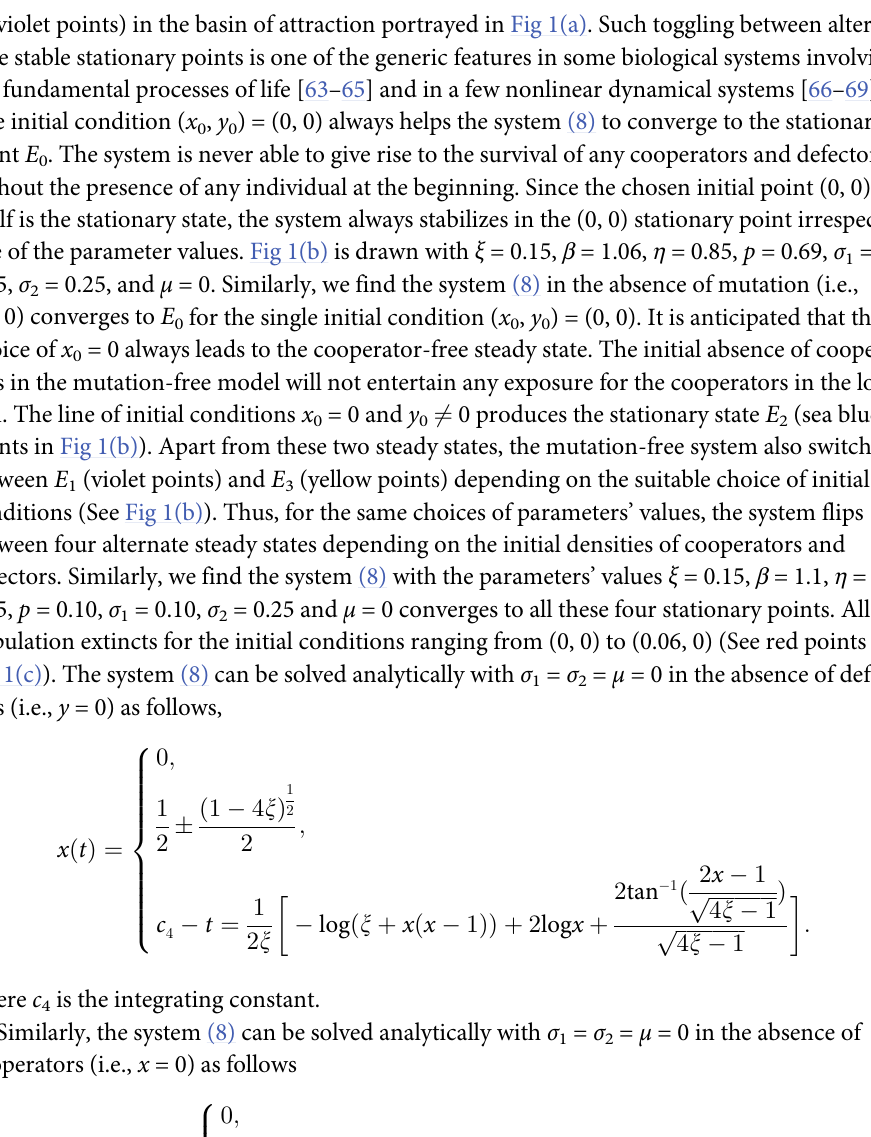
ffiffiffiffiffiffiffiffiffiffiffiffiffiffiffiffiffiffiffiffi p ð 2 p (cid:0) 1 Þ Z tan (cid:0) 1